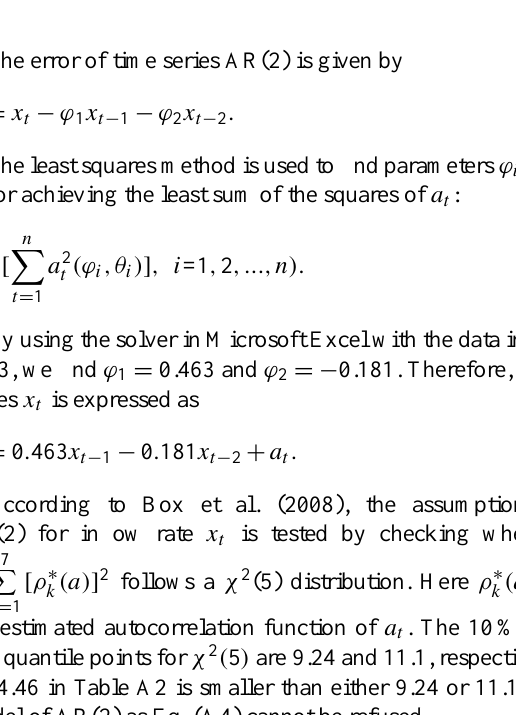
Table A1. The autocorrelation function and partial autocorrelation function for time series Q t . k 1 2 3 4 5 6 ρ k 0.42 0.01 − 0.09 − 0.12 0.00 0.13 ϕ kk 0.42 − 0.20 − 0.02 − 0.09 0.10 0.09 Table A2. The autocorrelation function for a t in time series Q t . k 1 2 3 4 5 6 7 31 ρ k 0.039 0.095 0.014 − 0.121 − 0.097 0.274 − 0.040 4.462 Table A3. The ψ weights for time series Q t in stage 1. l 1 2 3 4 5 6 7 8 9 ...* ψ l 0.463 0.034 − 0.068 − 0.038 − 0.005 0.004 0.003 0.001 − 2.7 × 10 − 4